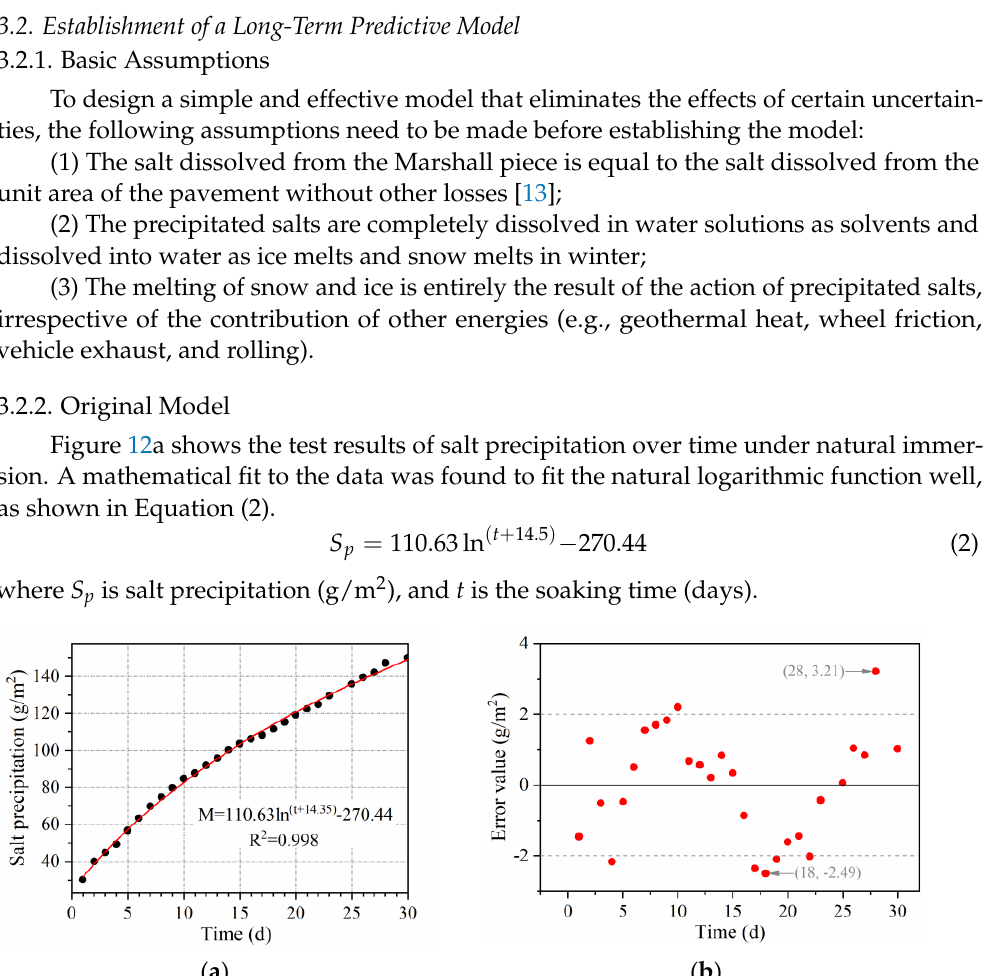
Figure 13. Effect of void ratio on salt precipitation. 3.2.4. Temperature Influence Coefficient The pattern of salt precipitation over time when the temperature was 20 °C, 30 °C, and 40 °C is shown in Figure 14. With increased temperature, salt precipitation increases. As the increase in temperature accelerates the movement of molecules. Furthermore, the increase in temperature causes the asphalt mixtures to soften, which reduces the binding of MFL, resulting in faster salt precipitation. Compared with salt precipitation at 20 °C, salt precipitation at 30 °C and salt precipitation at 40 °C are increased by approximately 1.5 and 1.8 times, respectively. Therefore, the average temperature influence coefficient is regarded as 1.65.